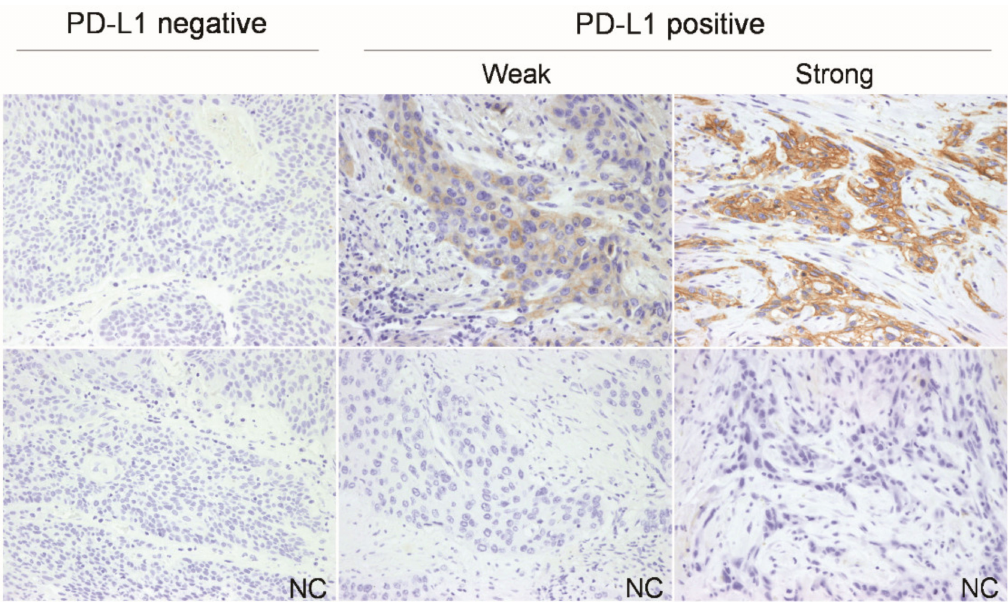
Figure1. RepresentativephotographsofPD-L1immunostaininginesophagealsquamouscellcarcinoma. The positive staining was assessed against the negative control staining (NC) (original magnification 200x). PD-L1, programmed death-ligand 1. Table 2. Associations between PD-L1 expression and clinicopathologic parameters.